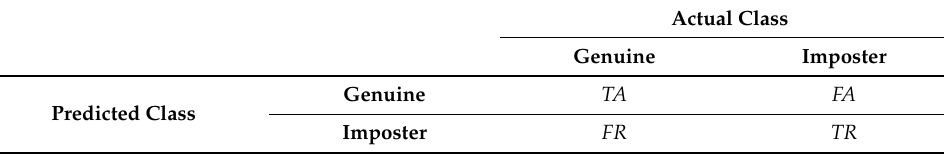
Table 4. Confusion